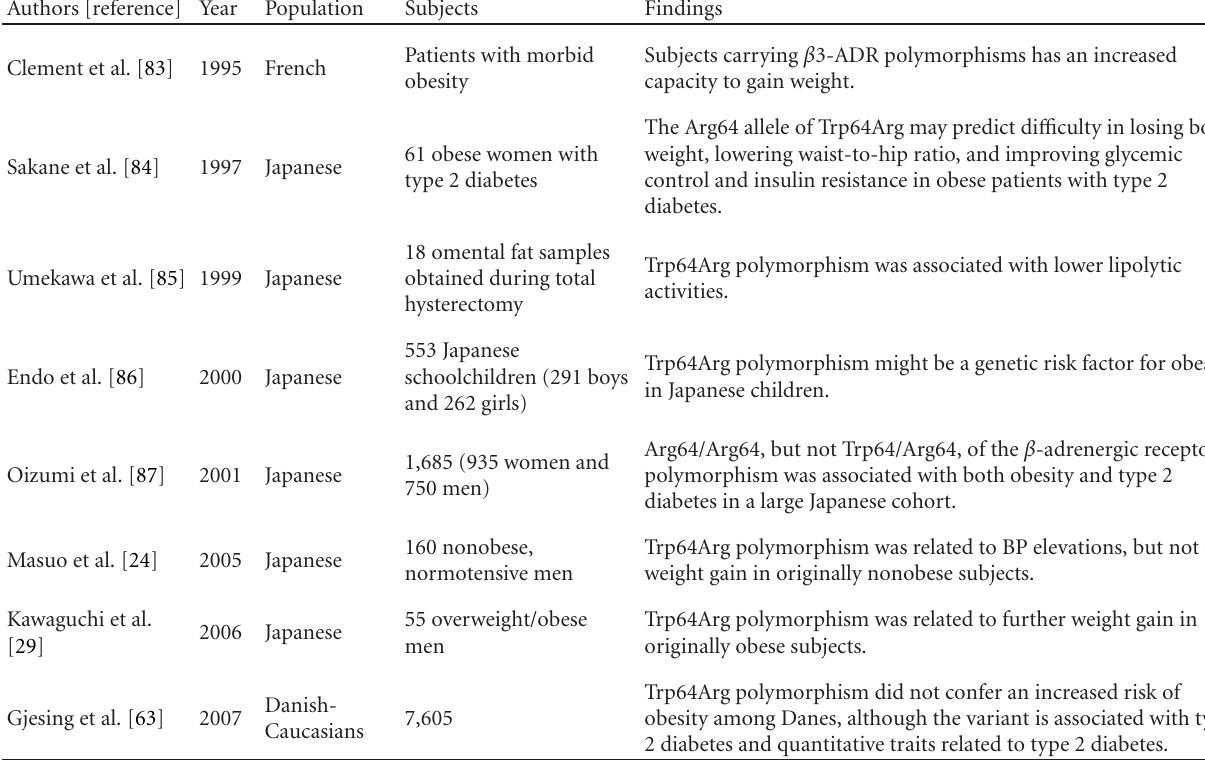
Table 3: Summary of studies showing associations between β 3-adrenoceptor polymorphisms and obesity.